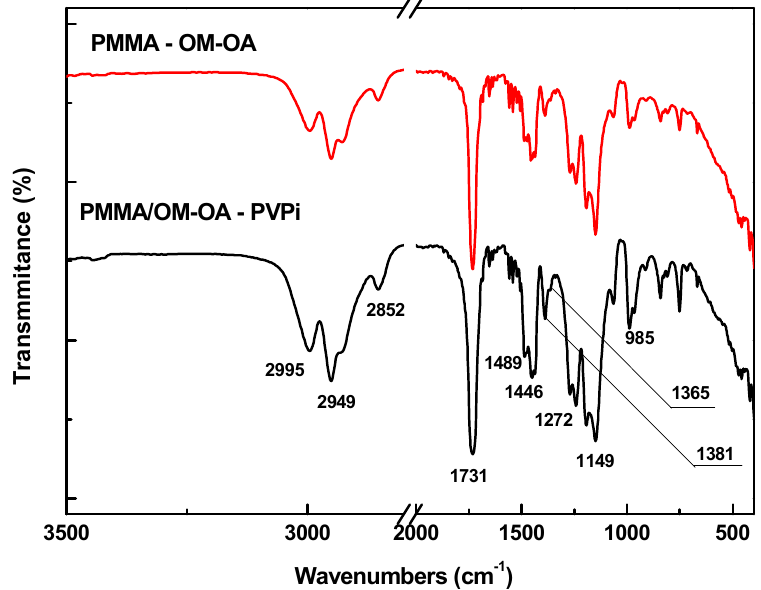
Figure 6. FTIR spectra of PMMA/OM-OA and PMMA/OM-OA/PVPi samples obtained from KBr pellets. Table 1. Main absorption bands obtained in FTIR spectra for PMMA/OM-OA and PMMA/OM- OA/PVPi samples and their vibrational assignments.